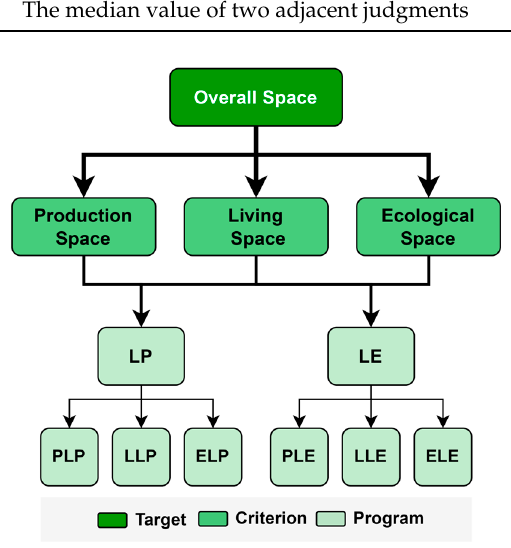
Figure 3. Analytic hierarchy model for spatial sustainable development. The RI values of the judgment matrix of orders 1–9 are presented in Table 3. Table 3. RI values of the mean random consistency